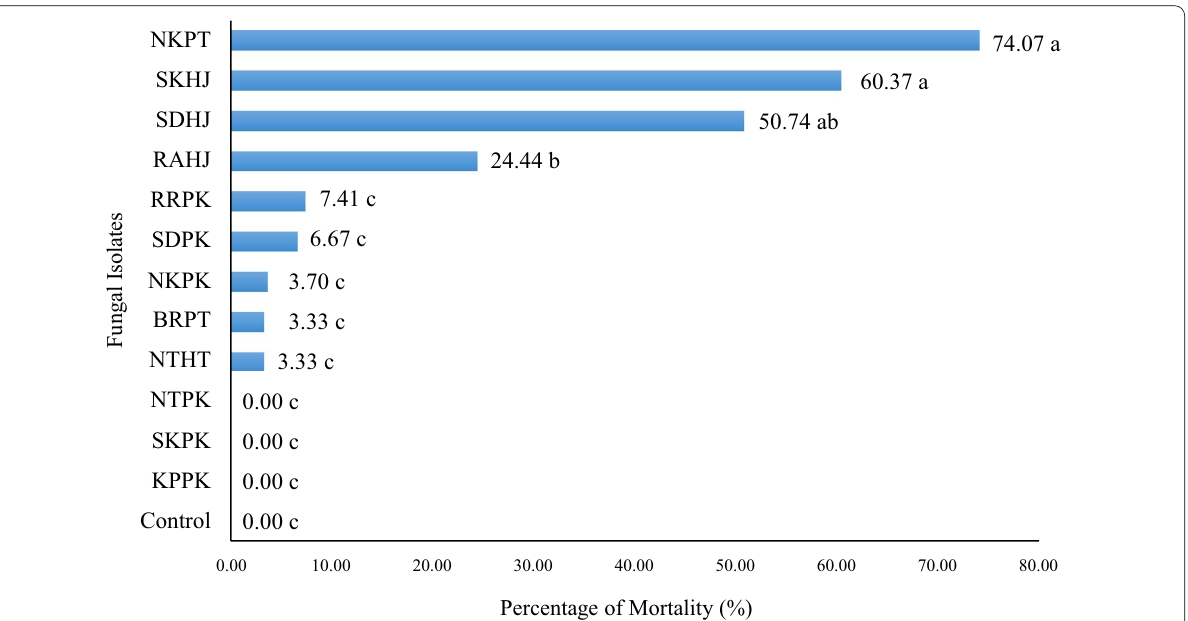
Fig. 1 Percentage of mortality of Spodoptera litura caused by fungal application. The numbers followed by the same letter are not significantly different based on least significant difference test (LSD) analysis at the 5% of significance level. Statistical analysis was performed on the data which were transformed using √ x 0.5. Treatments were arranged using a completely randomized design (CRD). The data are means collected from + observation of the mortality of 10 individuals of S. litura applied with entomopathogenic fungi. Assessment was conducted in 3